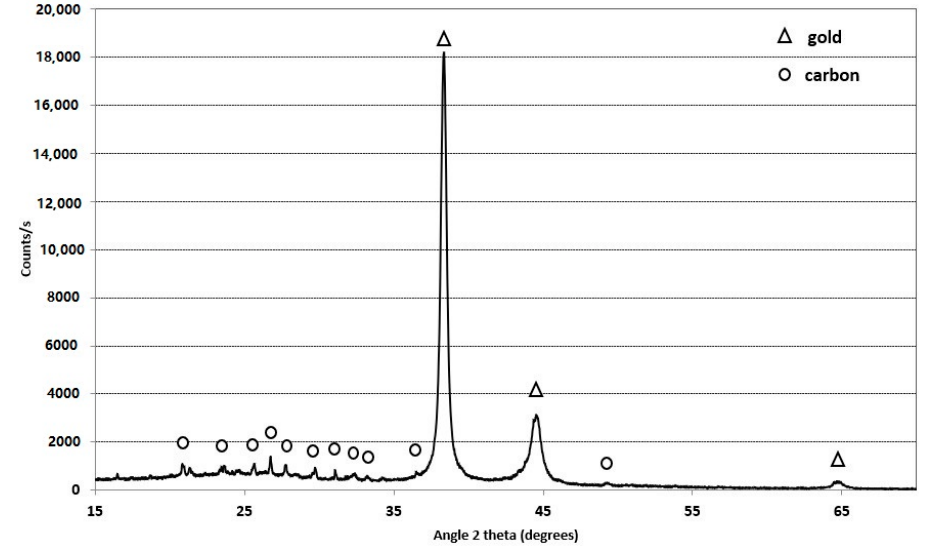
Figure 9. X-ray diffraction pattern of solid product obtained by electrowinning.